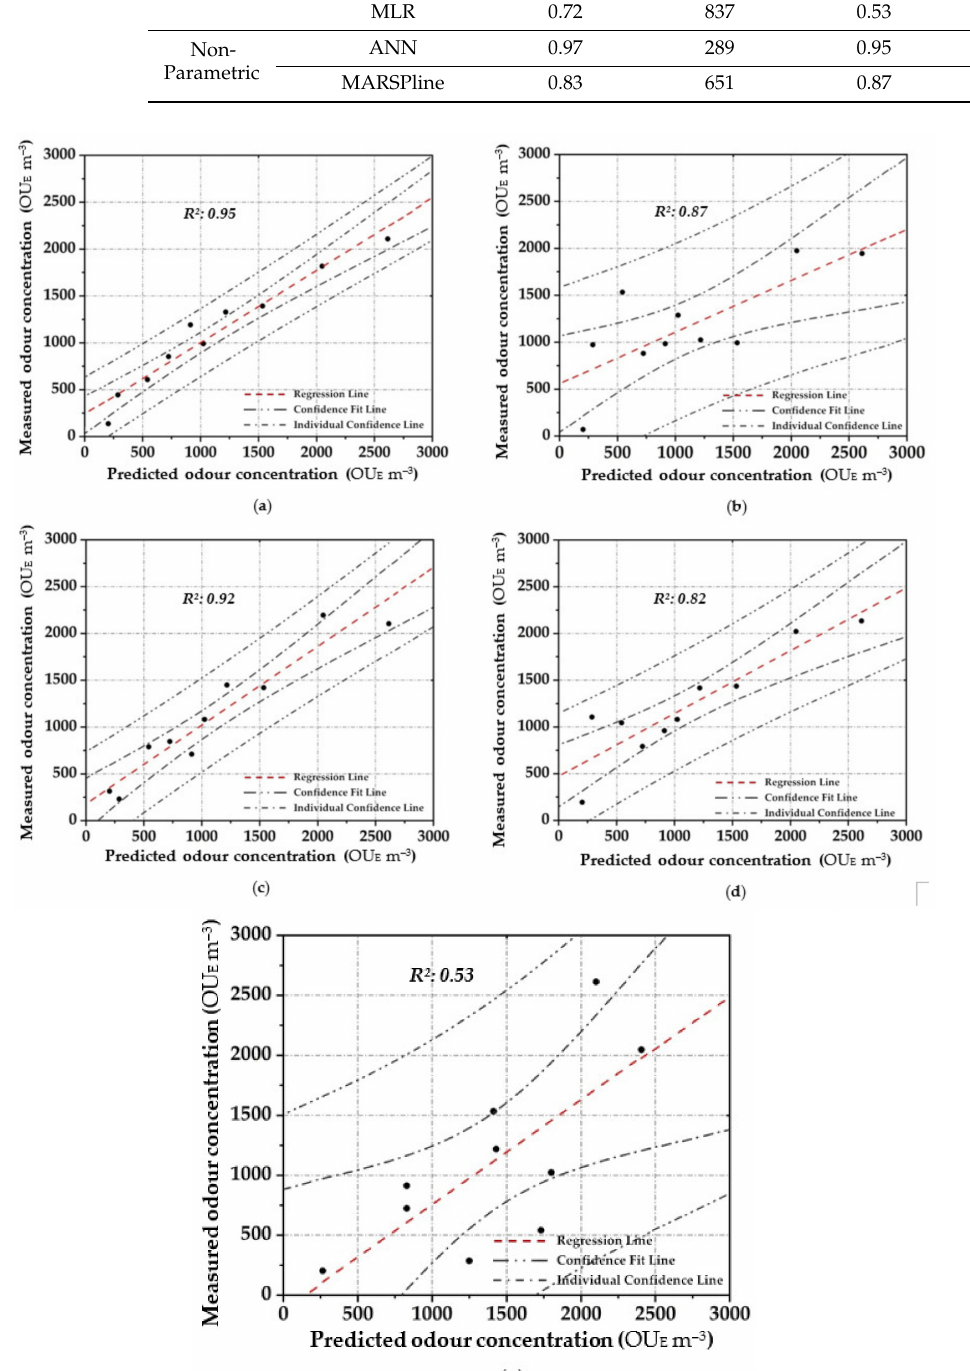
Figure 5. Scatter plot between the measured odour concentration with DO and the predicted one with the elaborated OQMMs using the different investigated prediction techniques and the validation dataset (( a )—ANN, ( b )—MARSPline, ( c )—PLS, ( d )—RSR and ( e